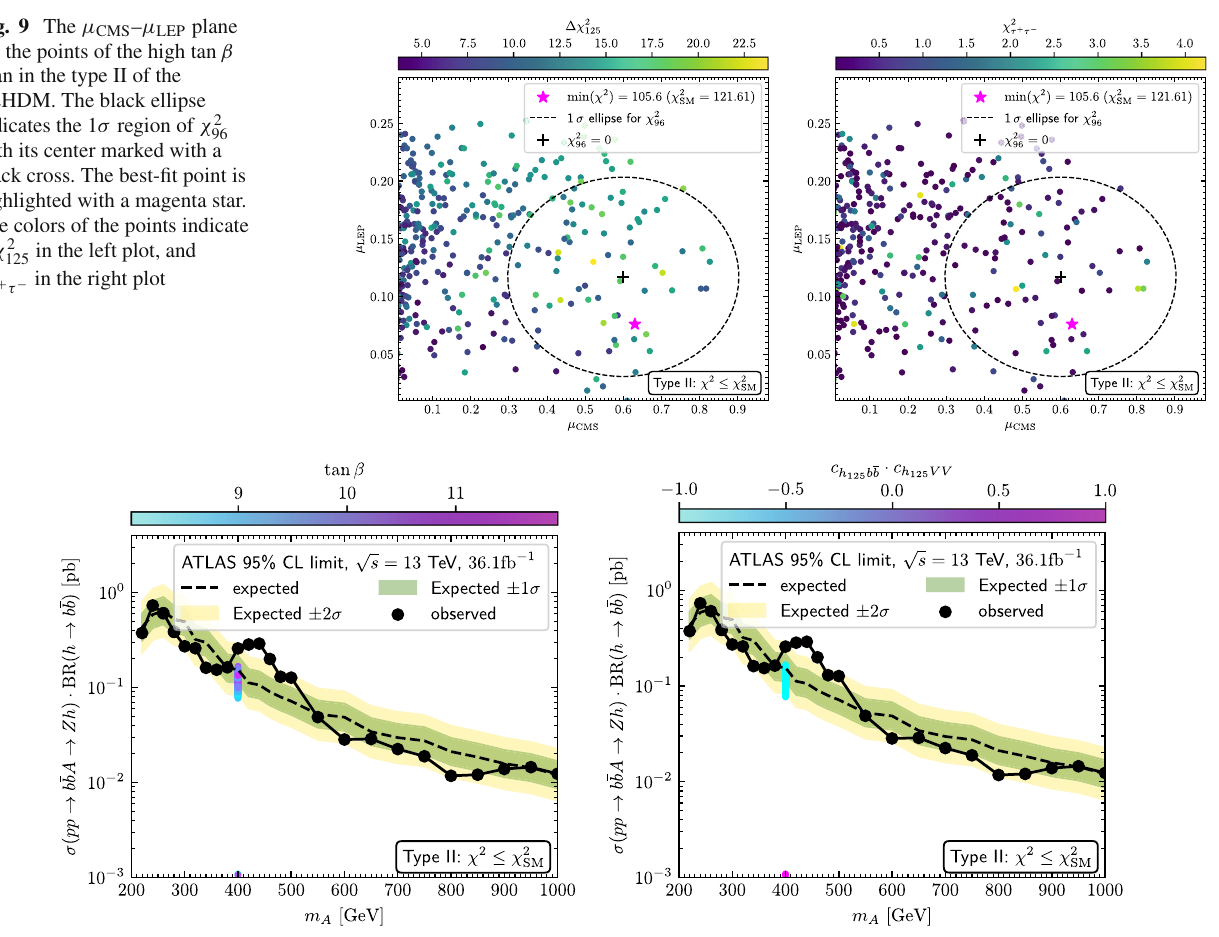
Fig. 10 Predicted rate for σ( b ¯ b → A → Zh 125 ) × BR ( h 125 → b ¯ b ) in comparison with the expected and observed 95% confidence level upper limits obtained by ATLAS [8]. The colors of the points indicate the value of tan β (left) and the value of the product c